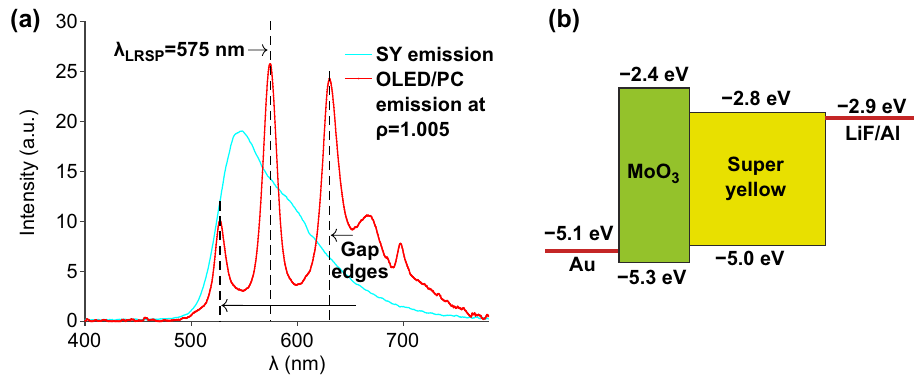
Fig. 2 a Electroluminescence spectrum from the 1D PC with the Super Yellow light-emitting layer, which is sandwiched between two metal nanolayers. The standard Super Yellow emission spectrum is presented as a cyan curve for comparison. b The energy level diagram of the OLED layers. (Color figure